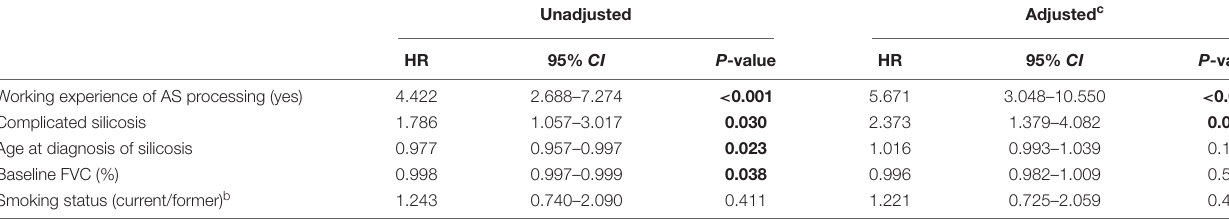
TABLE 3 | Factors associated with silicosis progress in multivariate Cox proportional hazards model a .